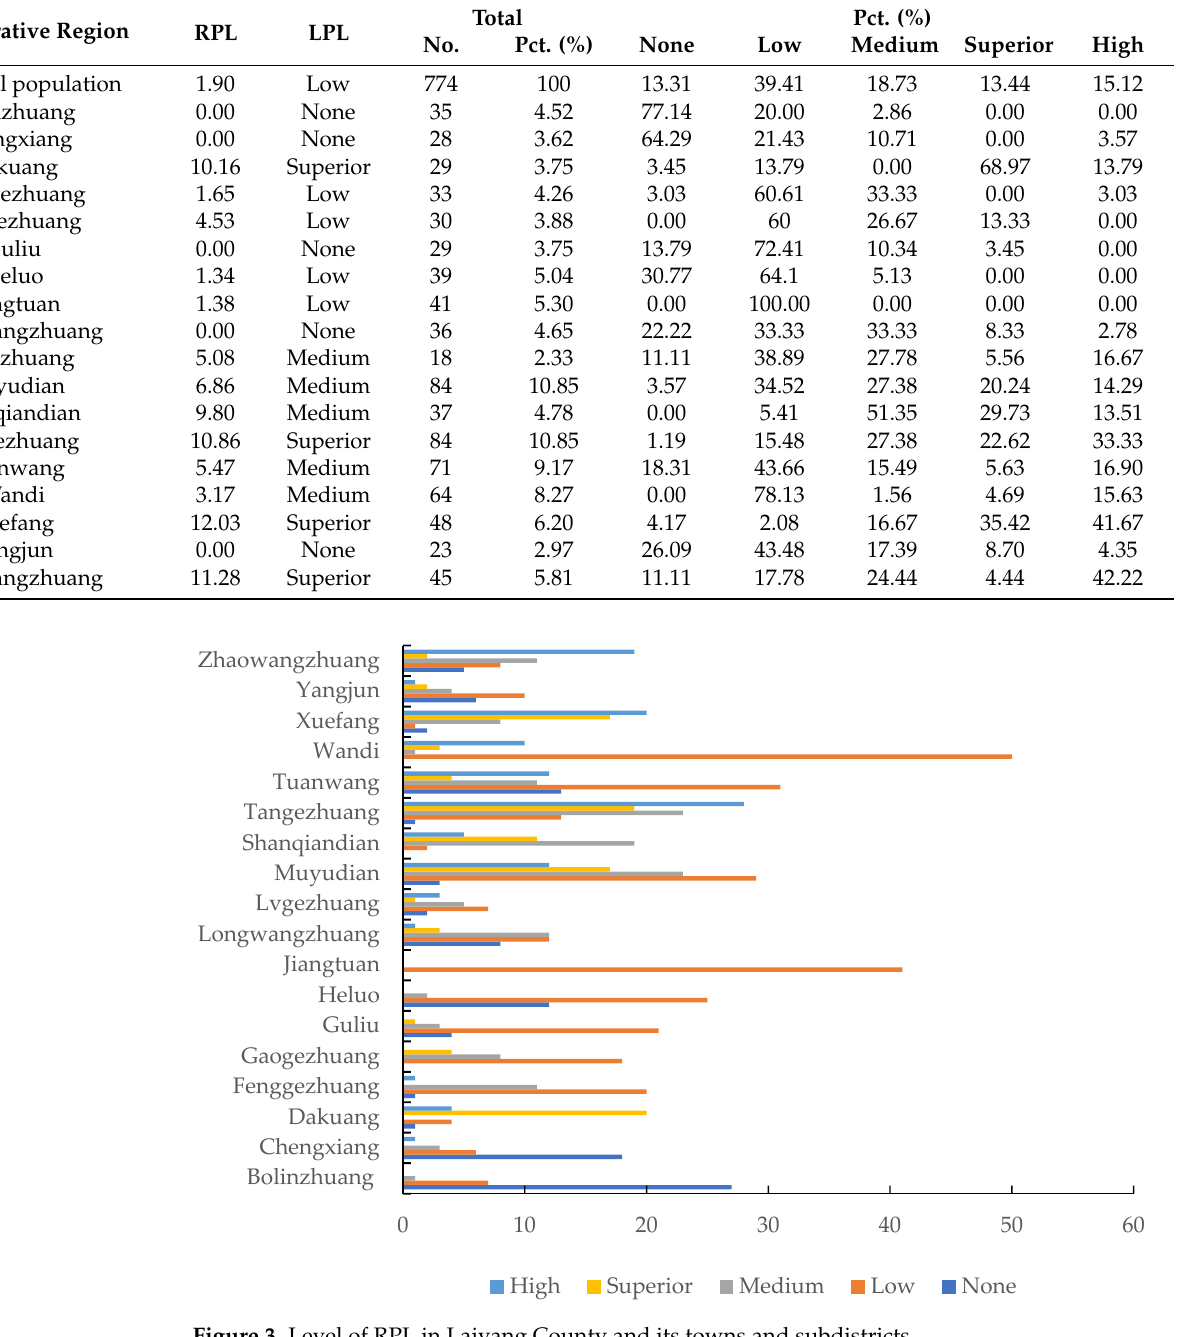
Figure 3. Level of RPL in Laiyang County and its towns and subdistricts.